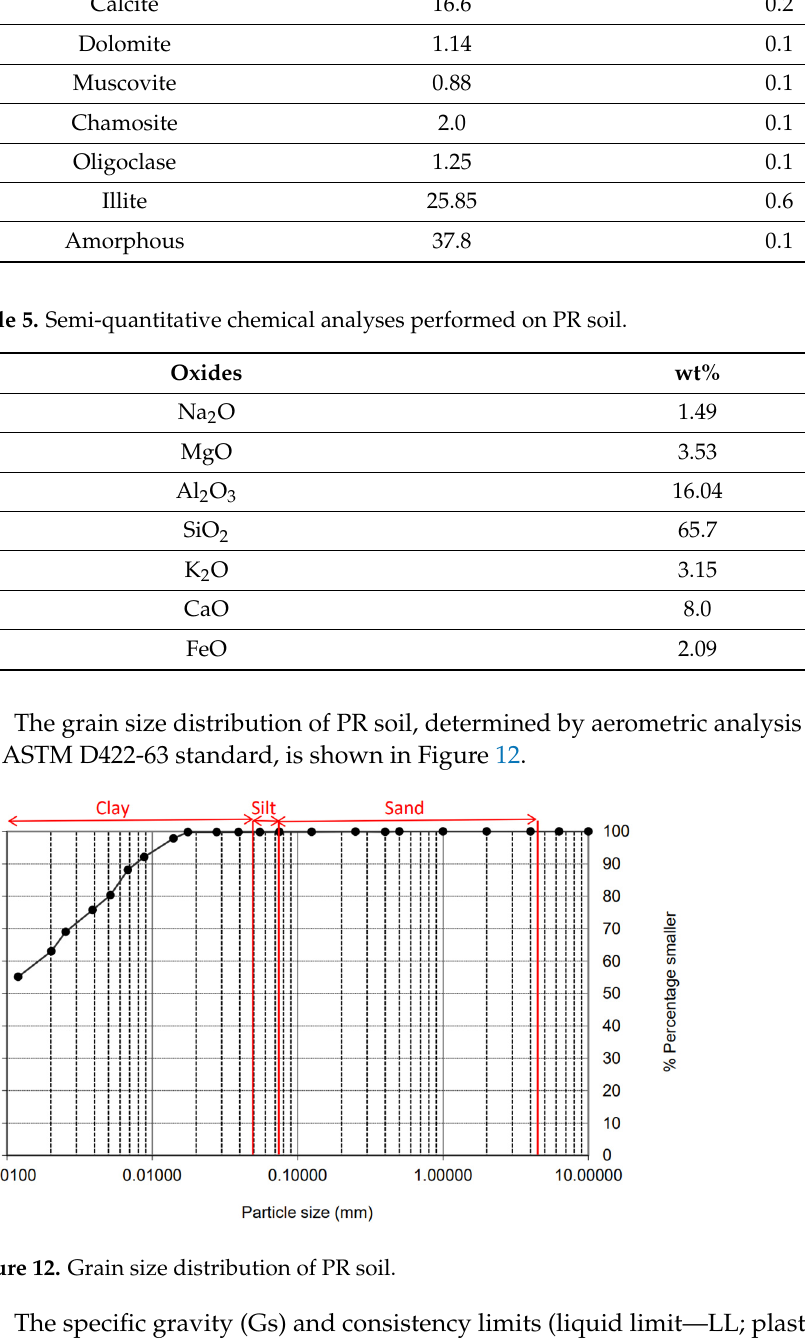
Table 4. Mineralogical composition of raw clayey soil (PR). Data are given as the weight percent (wt%), together with their relative errors (err) in the wt% quantification. Mineral Phase wt% Err. Quartz 14.51 0.1 Calcite 16.6 0.2 Dolomite 1.14 0.1 0.88 0.1